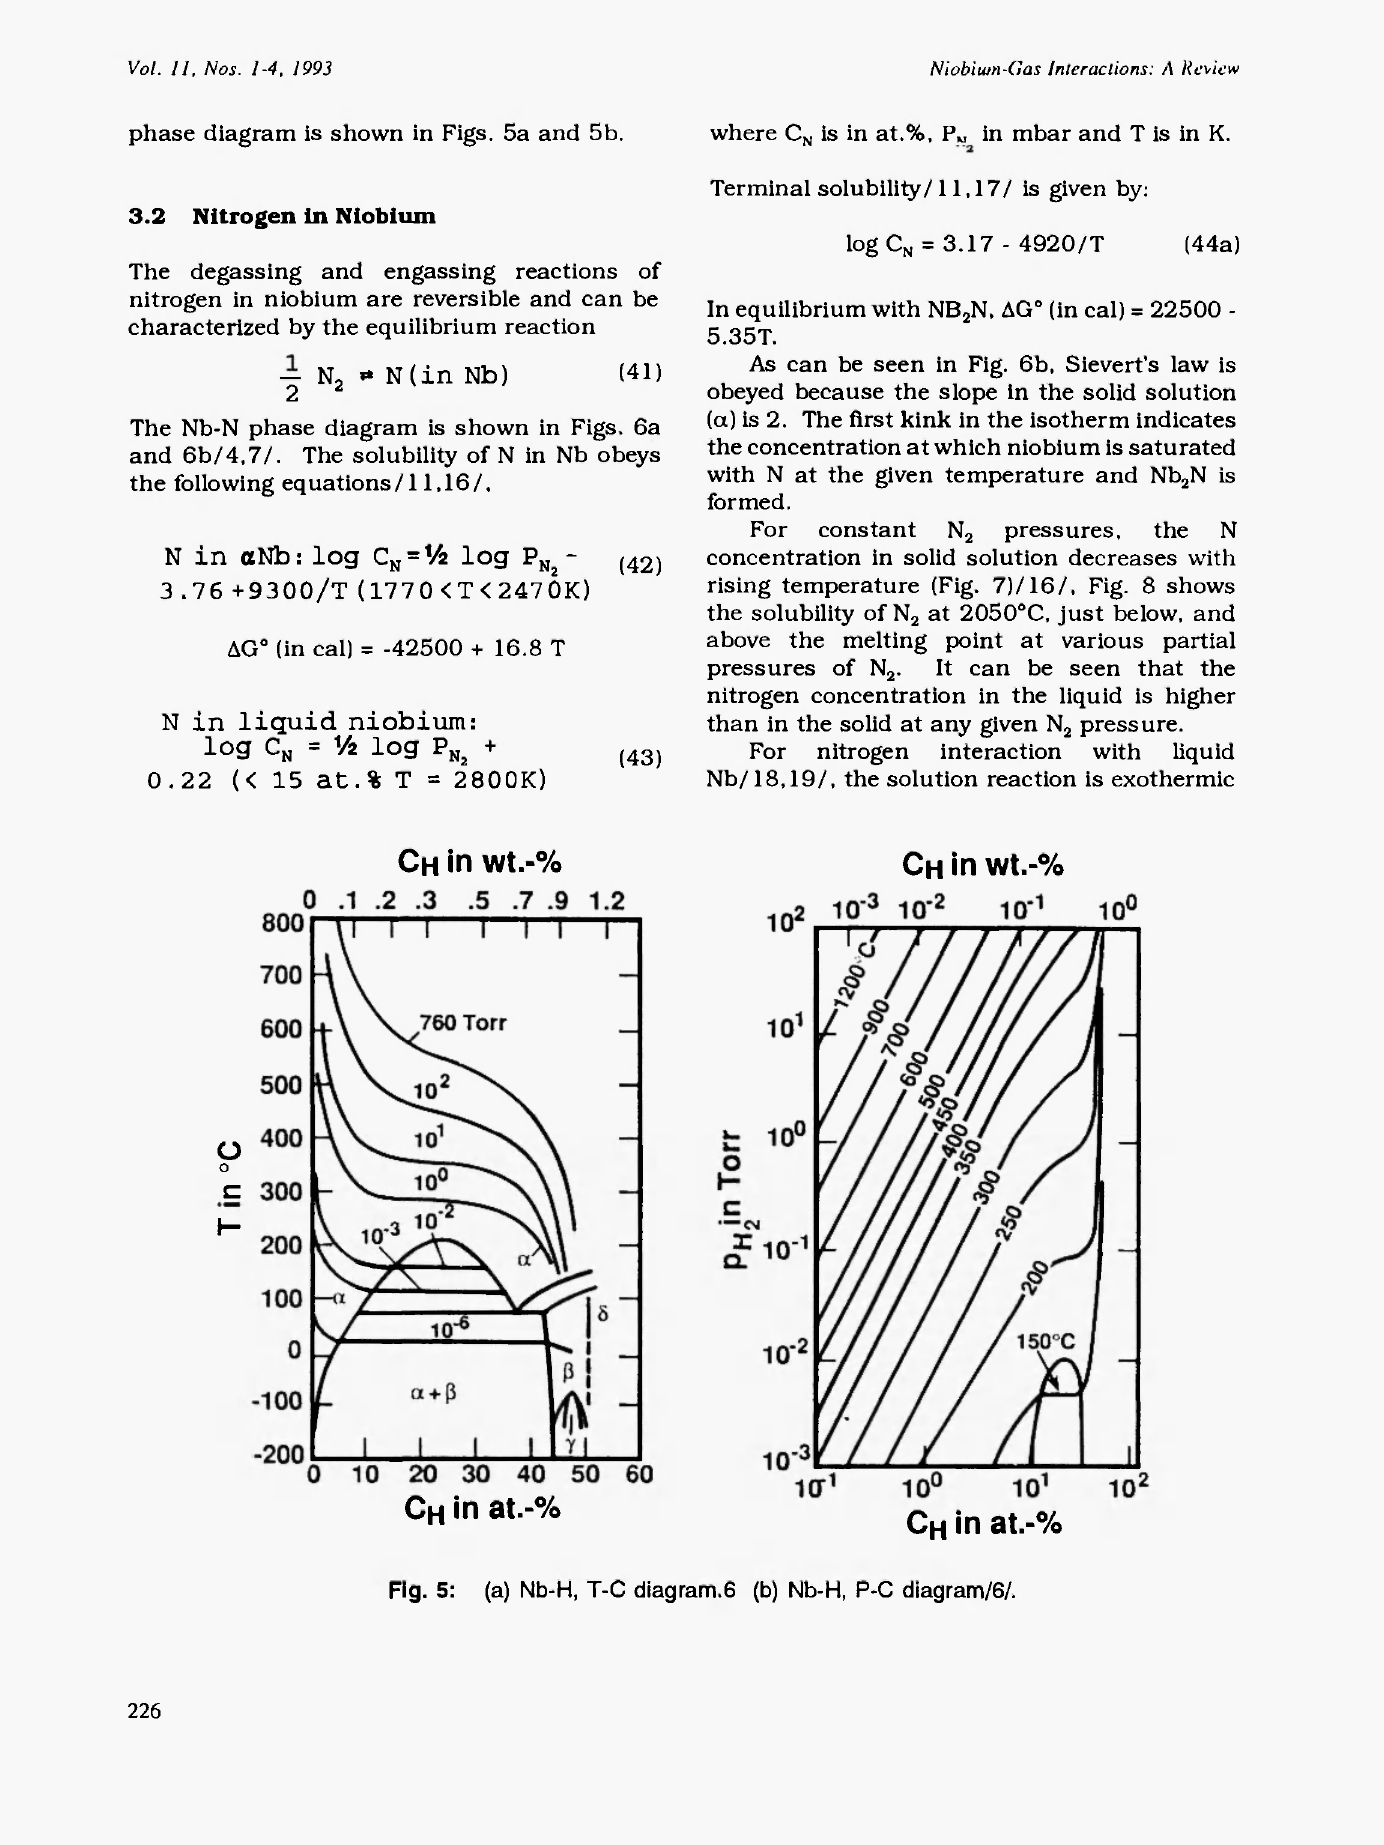
Ch in at.-% Fig. 5: (a) Nb-H, T-C diagram.6 (b) Nb-H, P-C diagram/6/.